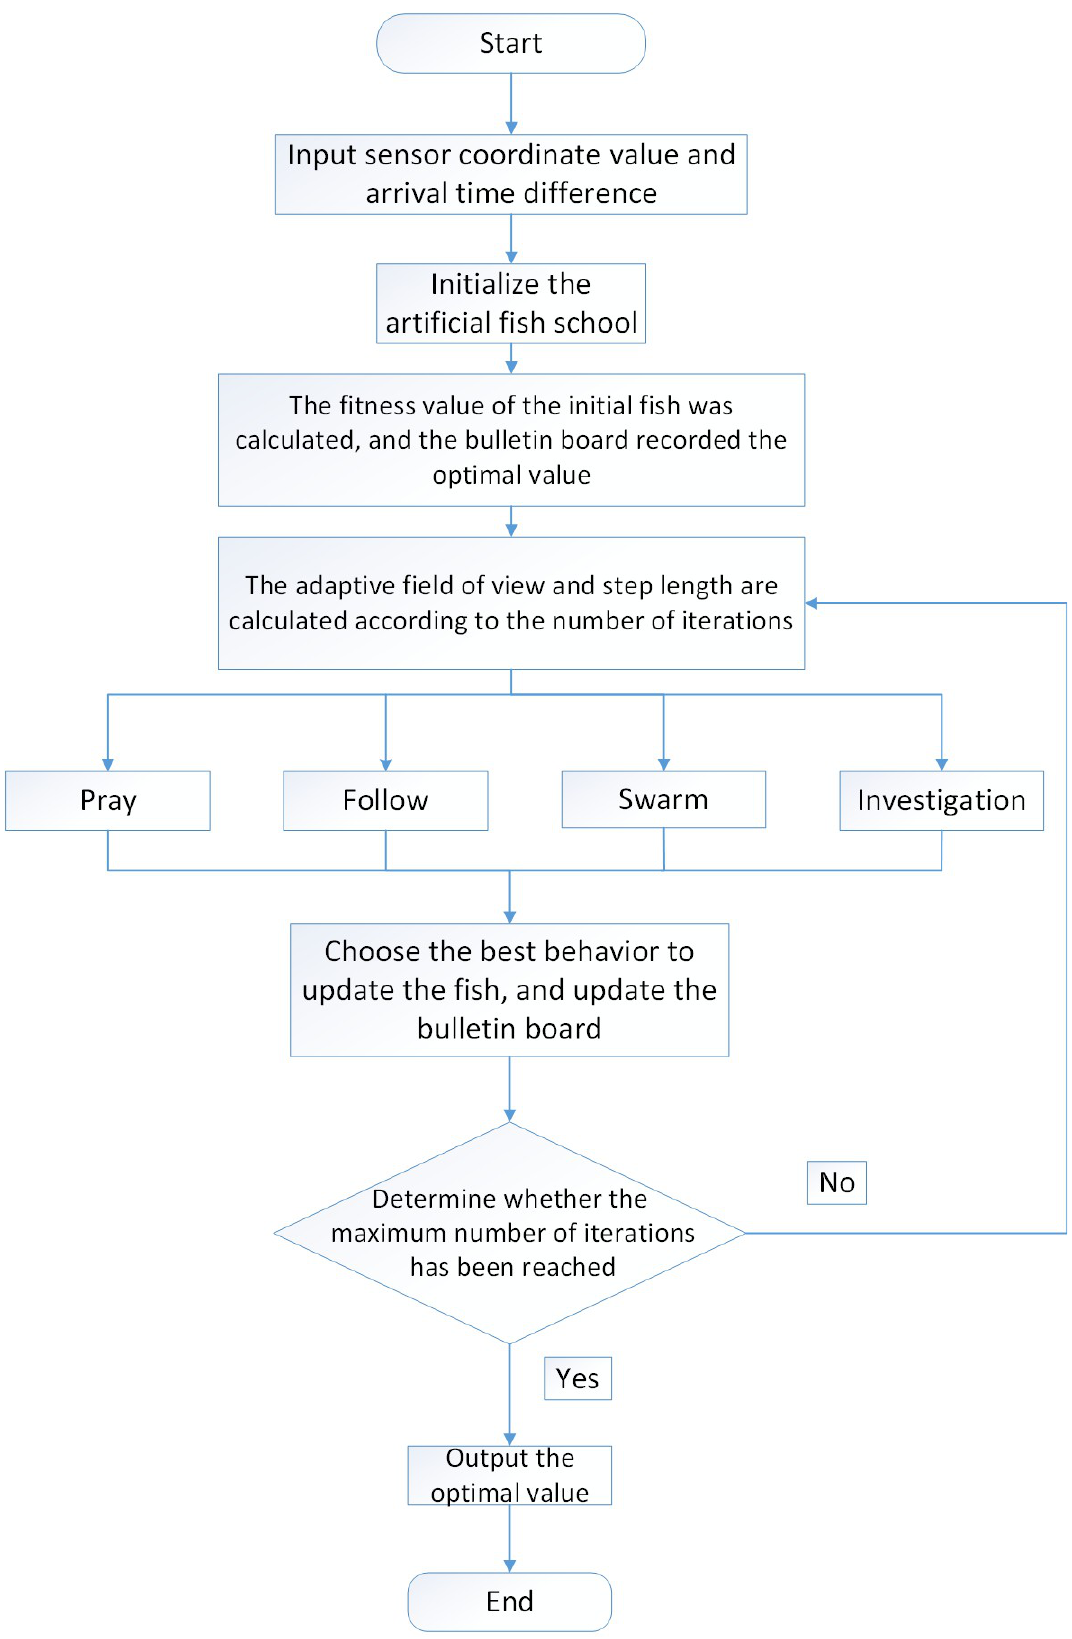
Figure 5. Flowchart of the